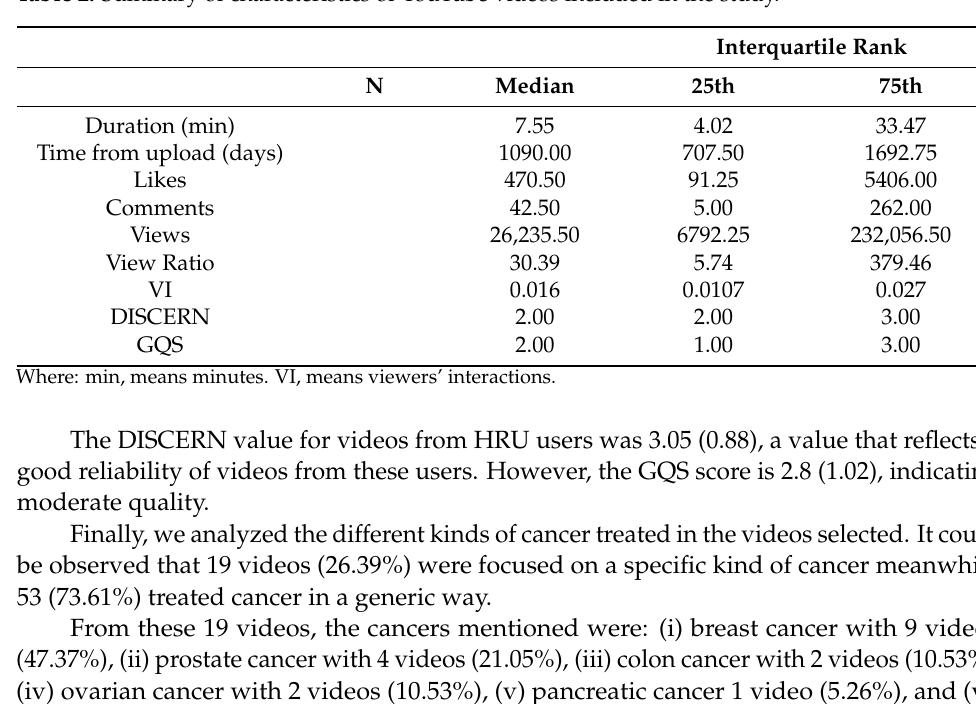
Table 2. Summary of characteristics of YouTube videos included in the